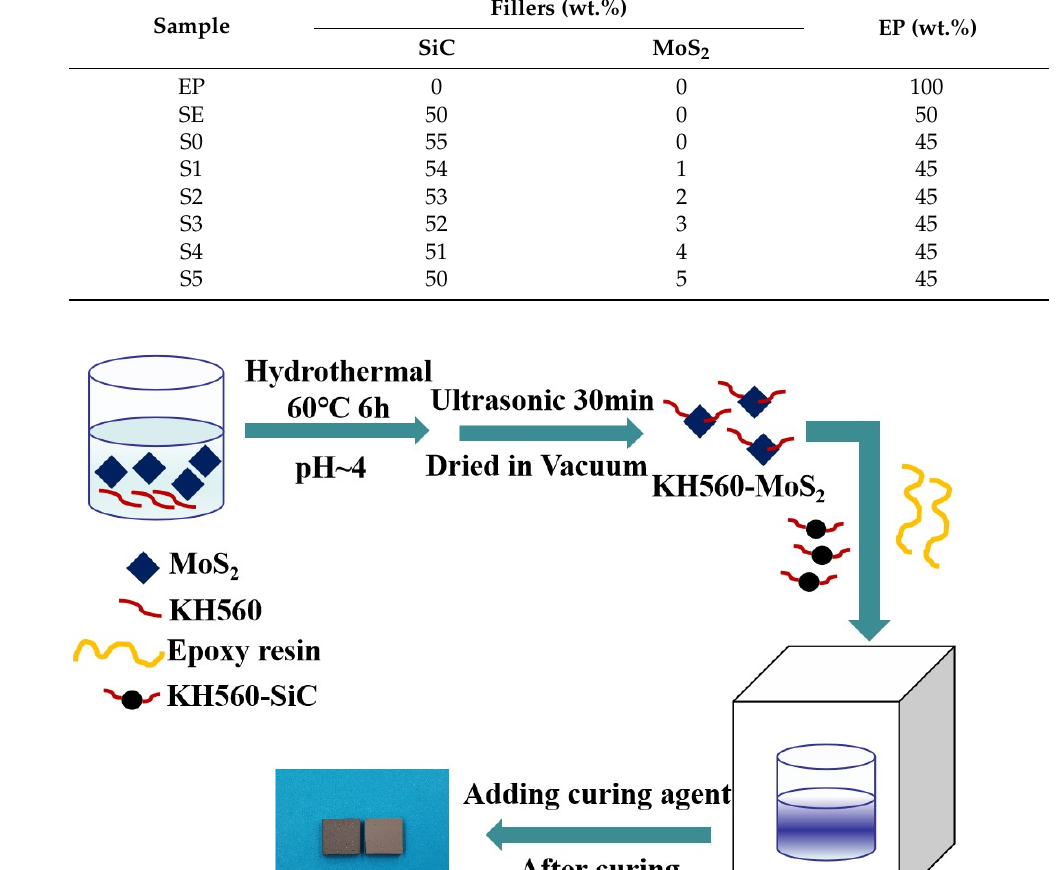
Table 1. Ingredients of epoxy composites.